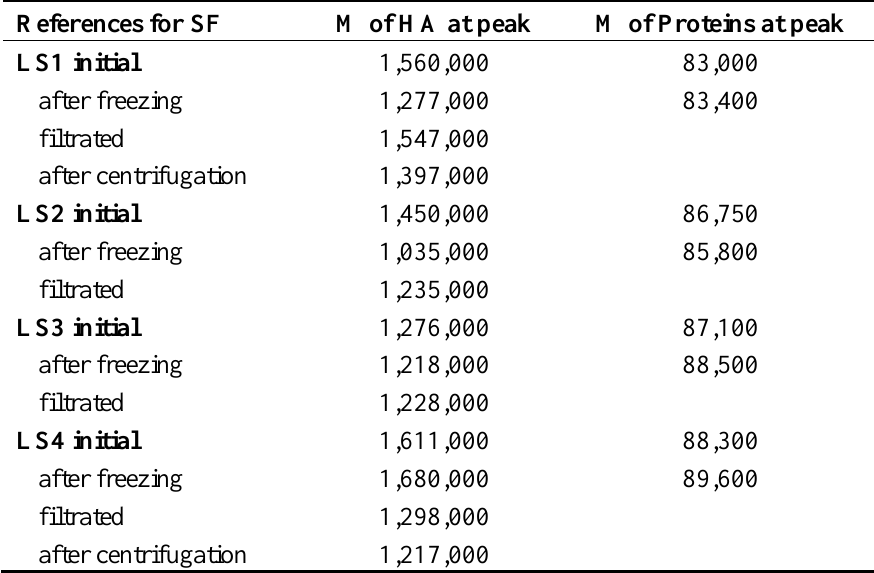
Table 2. Molecular weight of HA and proteins at the maximum of concentration peak signal in